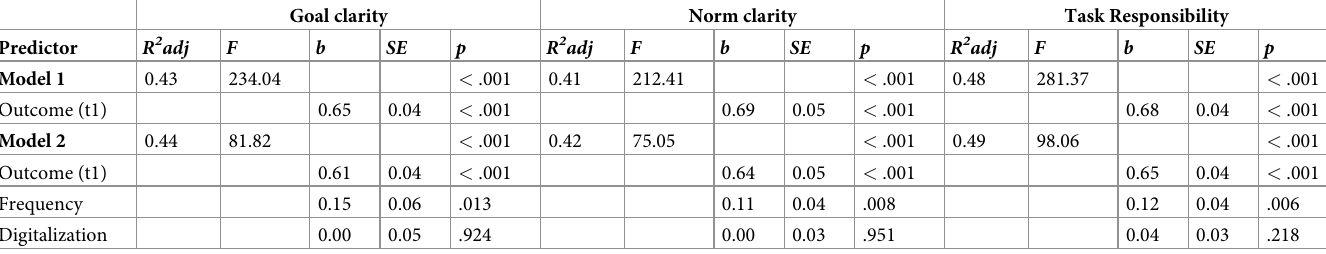
Table 4. Multiple regression analyses of Study 2 testing how digitalization and frequency of interaction (both t1) predict leadership outcomes (t2; N = 305). Goal